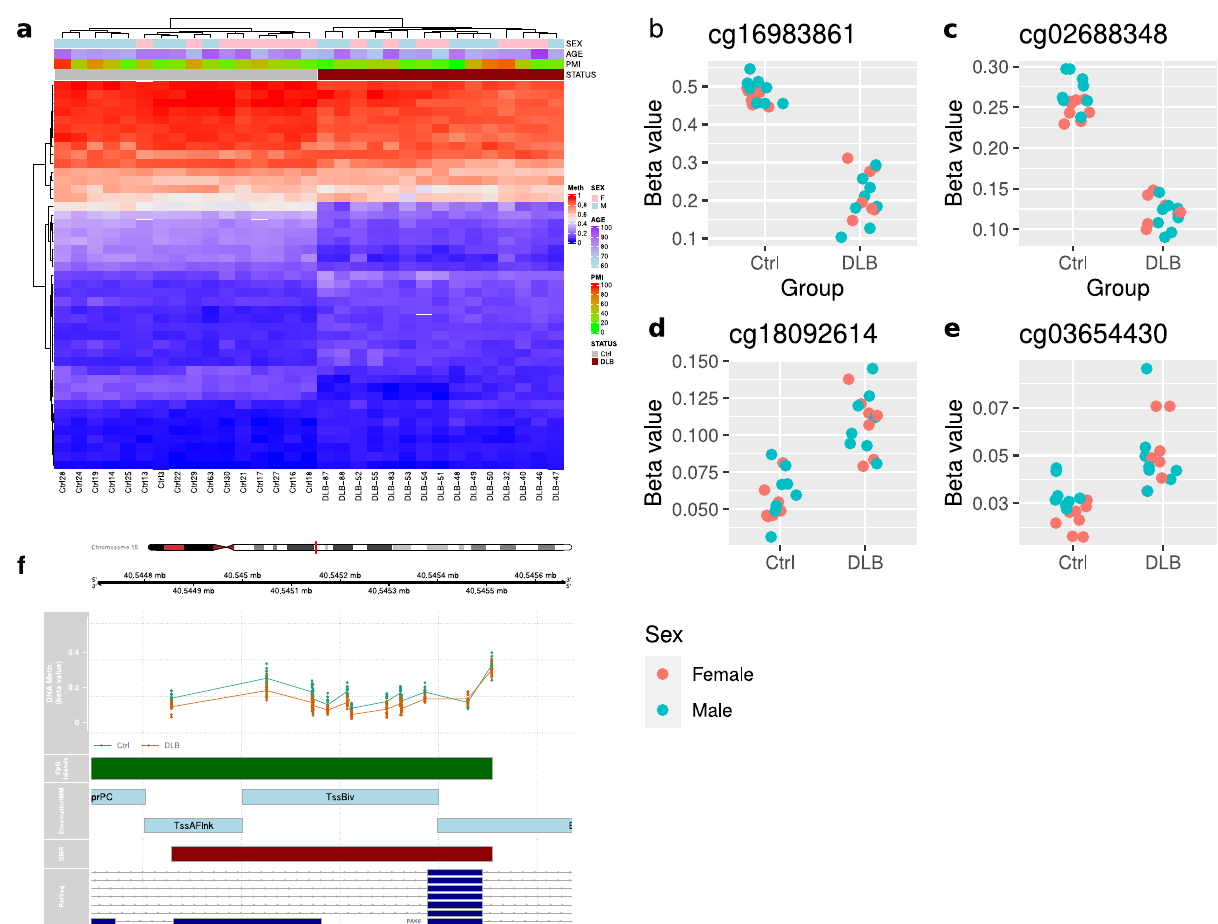
Fig. 2 DLB-associated DMCs and DMRs. a The heatmap plot of the signi fi cant DMCs with q-value < 0.1 (45 DMCs). The methylation level is scaled by row; blue represents low methylation level and red represents high methylation level. Different phenotype features (including sex, age, PMI and the DLB status) are illustrated in the top plots. b – e Scatterplot for the top 2 hypo and hyper DMCs. Samples are colored based on their biological sex. f Example of the top DMR (a region associated with the PAK6 ) at q-value < 0.1.